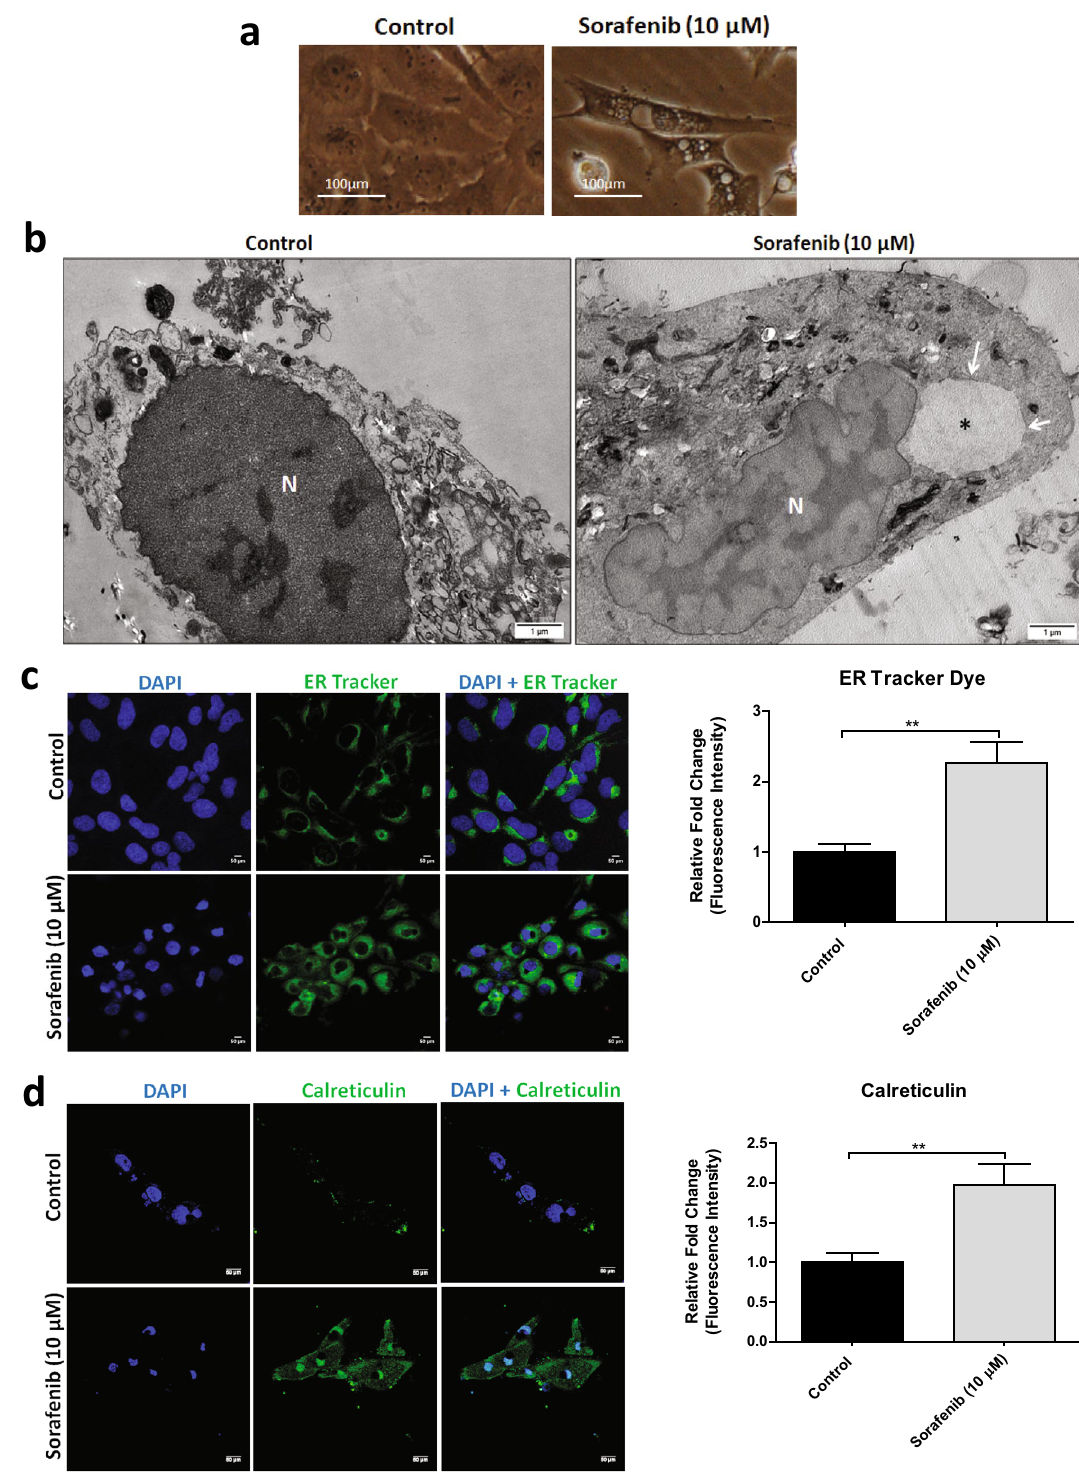
Figure 3. Dose dependent sorafenib induced cytoplasmic vacuolation in LX2 cells are due to ER stress. ( a , b ) Phase- contrast and Transmission electron micrograph (TEM) of untreated control and 10 µM sorafenib treated LX2 cells for 24 h. TEM images were taken using × 12,000 magnification, scale bar: 1 μm. Cytoplasmic vacuoles (asterisk, *) were observed in 10 µM sorafenib treated LX2 cells. ( c ) The confocal microscopic images of 10 μM sorafenib treated LX2 cells showed alteration of ER tracker along with cytoplasmic vacuolation with respective to untreated control after 24 h. Nuclei were stained with DAPI (4 ′ ,6-diamidino-2-phenylindole). ( d ) The confocal microscopic images showing enhanced calreticulin expression LX2 cells after 10 μM sorafenib treatment after 12 h. Relative fluorescence intensities of ER tracker dye and calreticulin in LX2 cells after exposure with 10 µM sorafenib in compare with untreated control were represented in a graph. The bars represent mean ± s.d. from three independent experiments (ns > 0.05, **P < 0.01 Student’s unpaired t